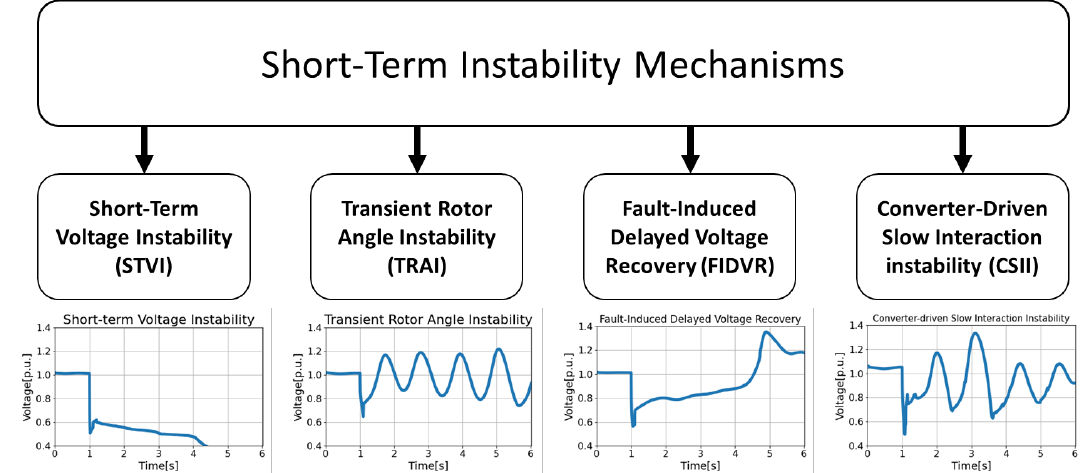
Figure 1. Division of short-term instability mechanisms discussed in this paper, accompanied by illustrative graphs of the post-disturbance voltage trajectory for each of the mechanisms.